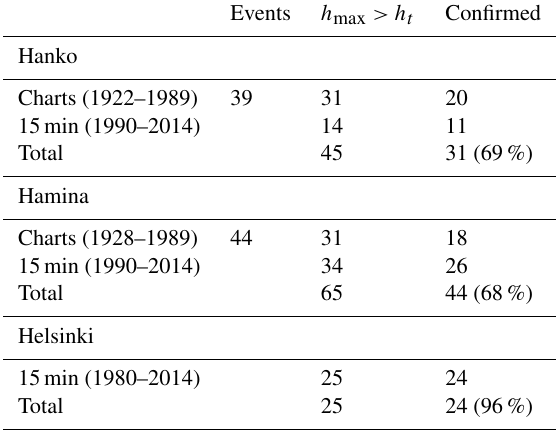
Table 1. Number of potential and confirmed meteotsunami events identified in the different data sets. The first column shows the num- ber of events found on the tide gauge charts based on visual in- spection. The second column gives the size of the final data set, which are events exceeding a station-specific height threshold h t . Confirmed events have a rapid change in air pressure occurring si- multaneously with the sea level oscillations. The rest could not be confirmed because of missing or inconclusive air pressure